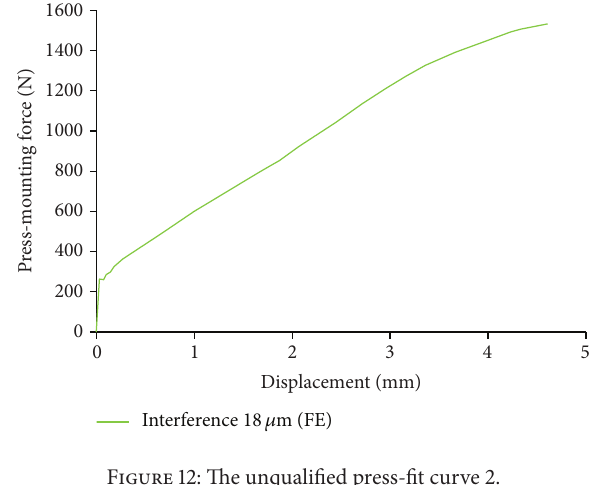
Figure 12: The unqualified press-fit curve 2.